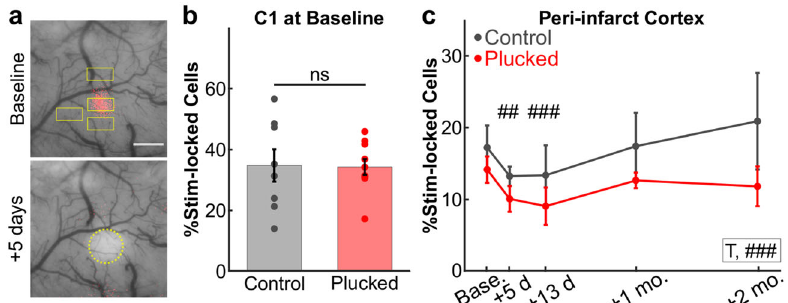
Fig. 5 Forced use therapy does not lead to an increase in the number of whisker-responsive cells in peri-infarct cortex. a Representative ISI maps depicting C1 whisker-evoked activity (red) overlaid on a photograph of the cranial window at baseline (top) or 5 days post-stroke (bottom). Yellow rectangles indicate the locations of calcium imaging fi elds-of-view throughout the peri-infarct region. Stroke at + 5 days outlined in yellow circle. b Percentage of L2/3 neurons in the C1 barrel with stimulus-locked responses to C1 whisker stimulation at baseline prior to stroke in control (gray, n = 8) or forced use whisker-plucked (red, n = 10) groups. Two-sample t test, p = 0.929. Data represent mean ± s.e.m., with individual dots for each mouse overlaid. c Percentage of neurons with stimulus-locked responses to C1 whisker stimulation in the peri-infarct regions throughout recovery in control (gray) and whisker-plucked (red) groups ( n = 8 and 10 mice, respectively, except n = 8 for forced use group at + 2 months). GLME binomial model with separate groups, ANOVA for fi xed effects of group (G, p = 0.338), timepoint (T, p = 0.208), and group-by-timepoint interaction (G:T, p = 0.554) were not signi fi cant. GLME binomial model with pooled groups, ANOVA for fi xed effect of timepoint (T, ### p = <0.001), with signi fi cance for individual coef fi cients for timepoints (T), corrected using Benjamini and Hochberg ’ s method, indicated over corresponding data points (## p < 0.01; ### p < 0.001). Data represent mean ±